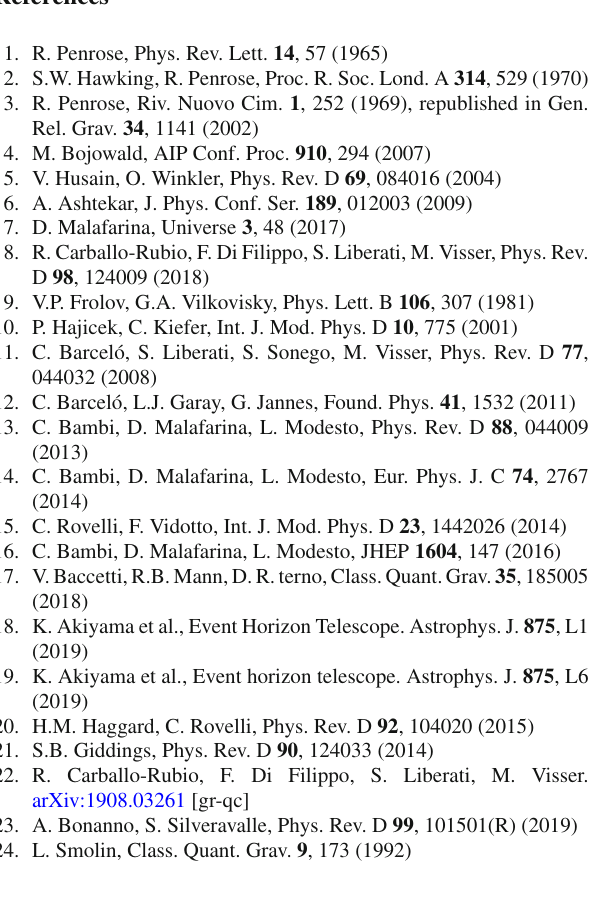
Fig. 6 The left panel shows the apparent horizon curve r Iah ( t I ) for the collapsing phase with the solid line representing quantum inspired col- lapse and the dashed line representing classical collapse. The middle panel shows the apparent horizon curve r IIah ( t II ) for the expanding